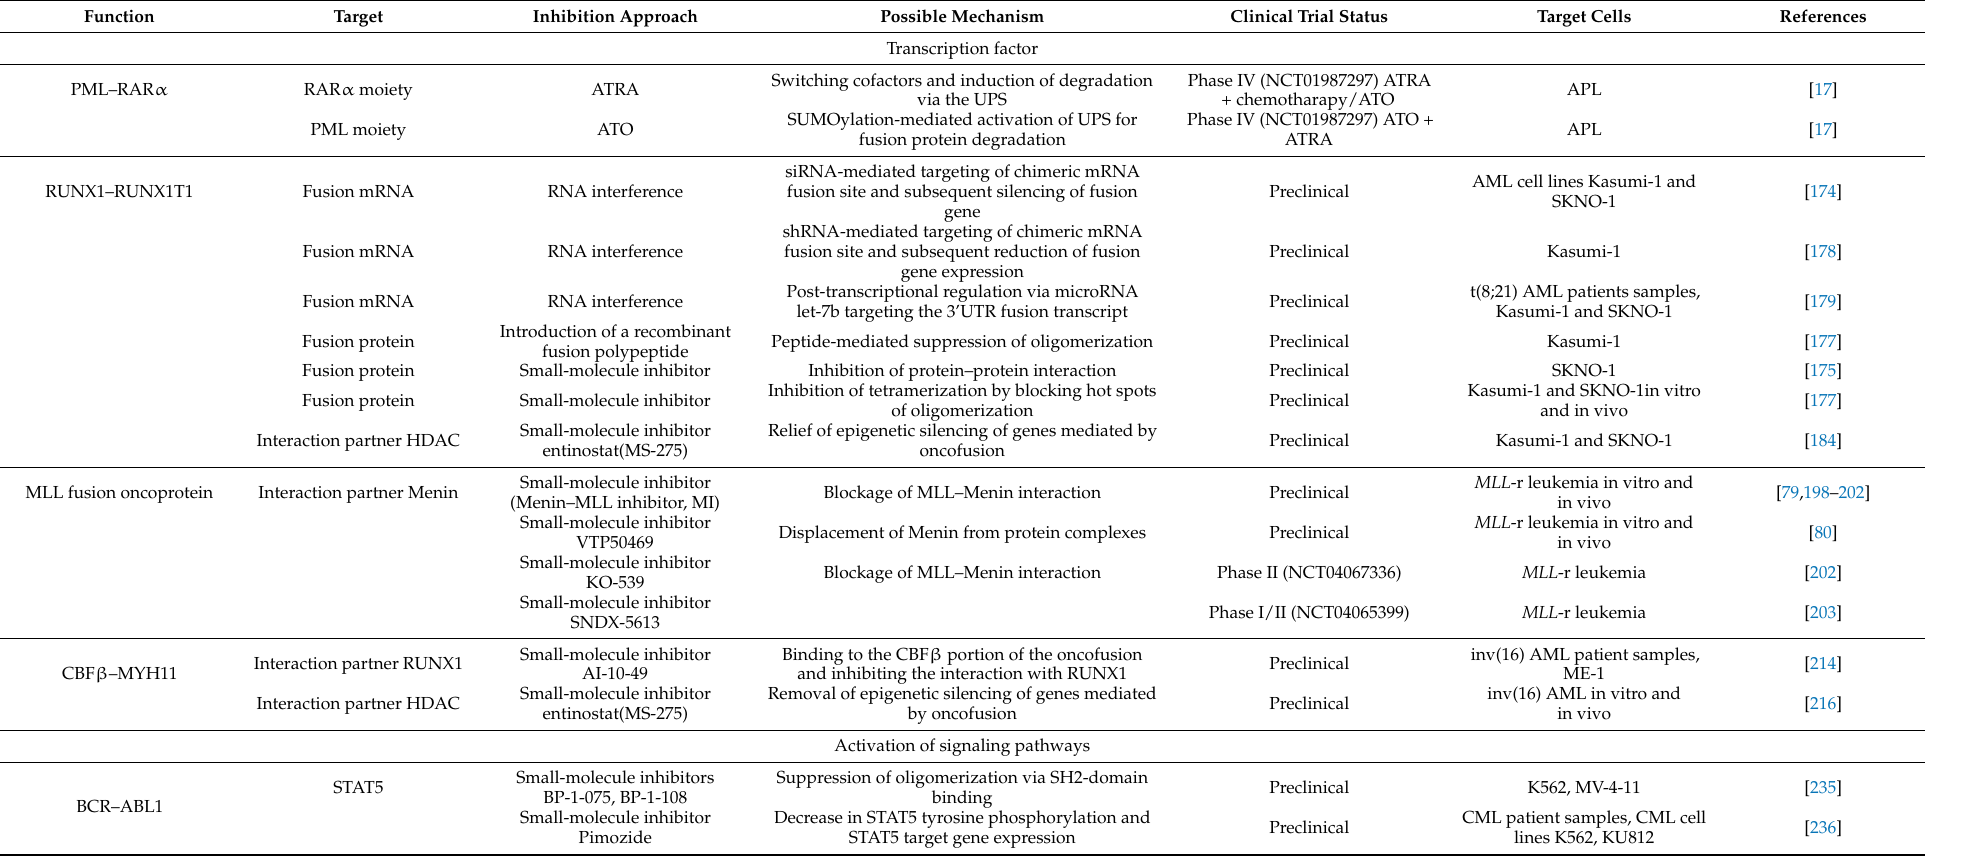
Table 4. Inhibitors of fusion TFs and their partners: predicted mechanism of action and the stage of